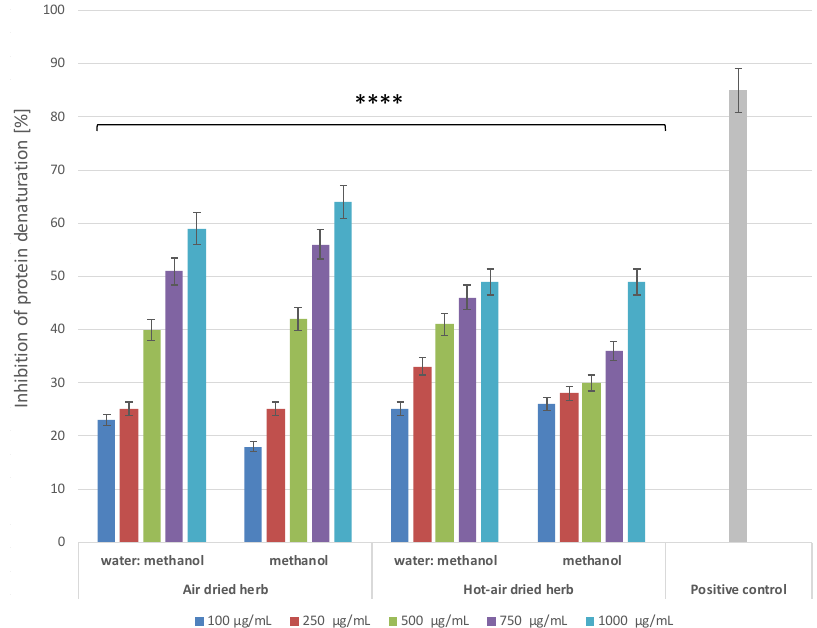
Figure 6. Effect of B. officinalis extracts on inhibition of BSA protein denaturation. Data are the means of three independent experiments. **** p < 0.0001 versus the control.